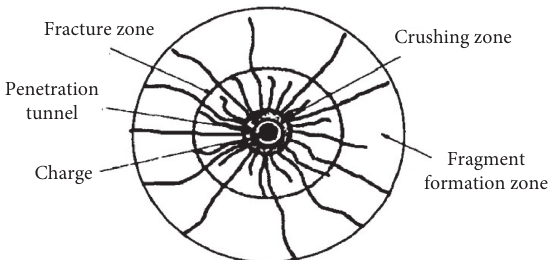
Figure 14: Schematic of crushing zone, fracture zone, and frag- ment formation zone.